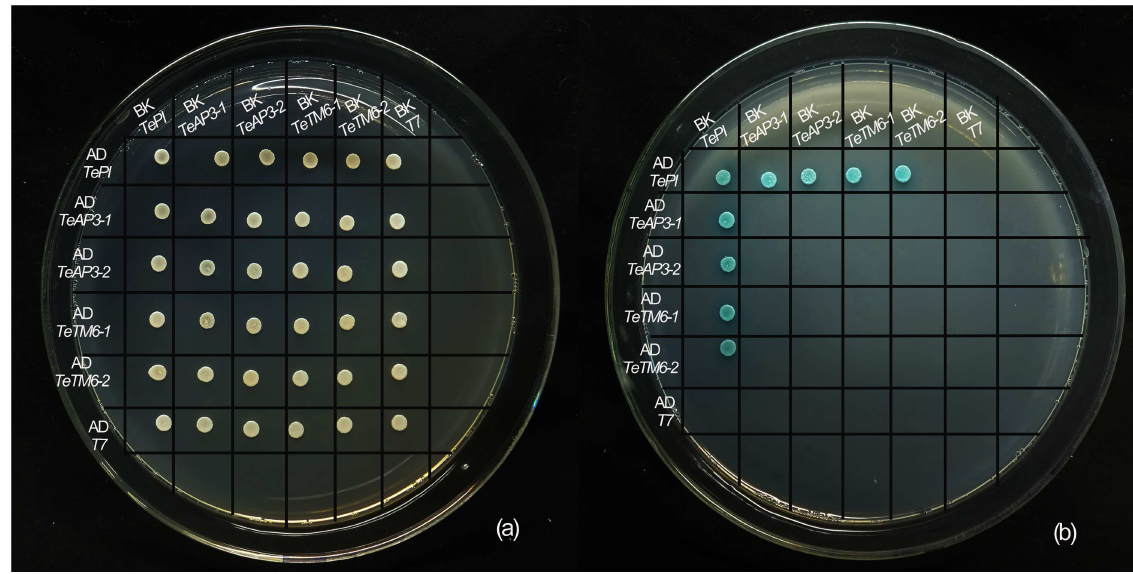
Fig 5. Yeast two-hybrid interactions of five MADS-box B class proteins of T . erecta . The PCR products were introduced into the GAL4-based yeast two-hybrid vectors pGADT7 vector (AD) and pGBKT7 vector (BK) and co-transformed into the AH109 yeast strain. (a) Co-transformed yeast cells were plated on selectionplates SD / -Trp-Leu-solid medium. (b) Yeast growth on selection plates SD / -Trp-Leu-His-Ade / X- α -GAL solid medium showedthat TePI protein could interact with other four AP3/TM6-like proteins. No homodimeror interactionbetweenthe AP3/TM6-like proteinswas observed in T . erecta . Besides, we observedhomodimerization in TePI proteins.